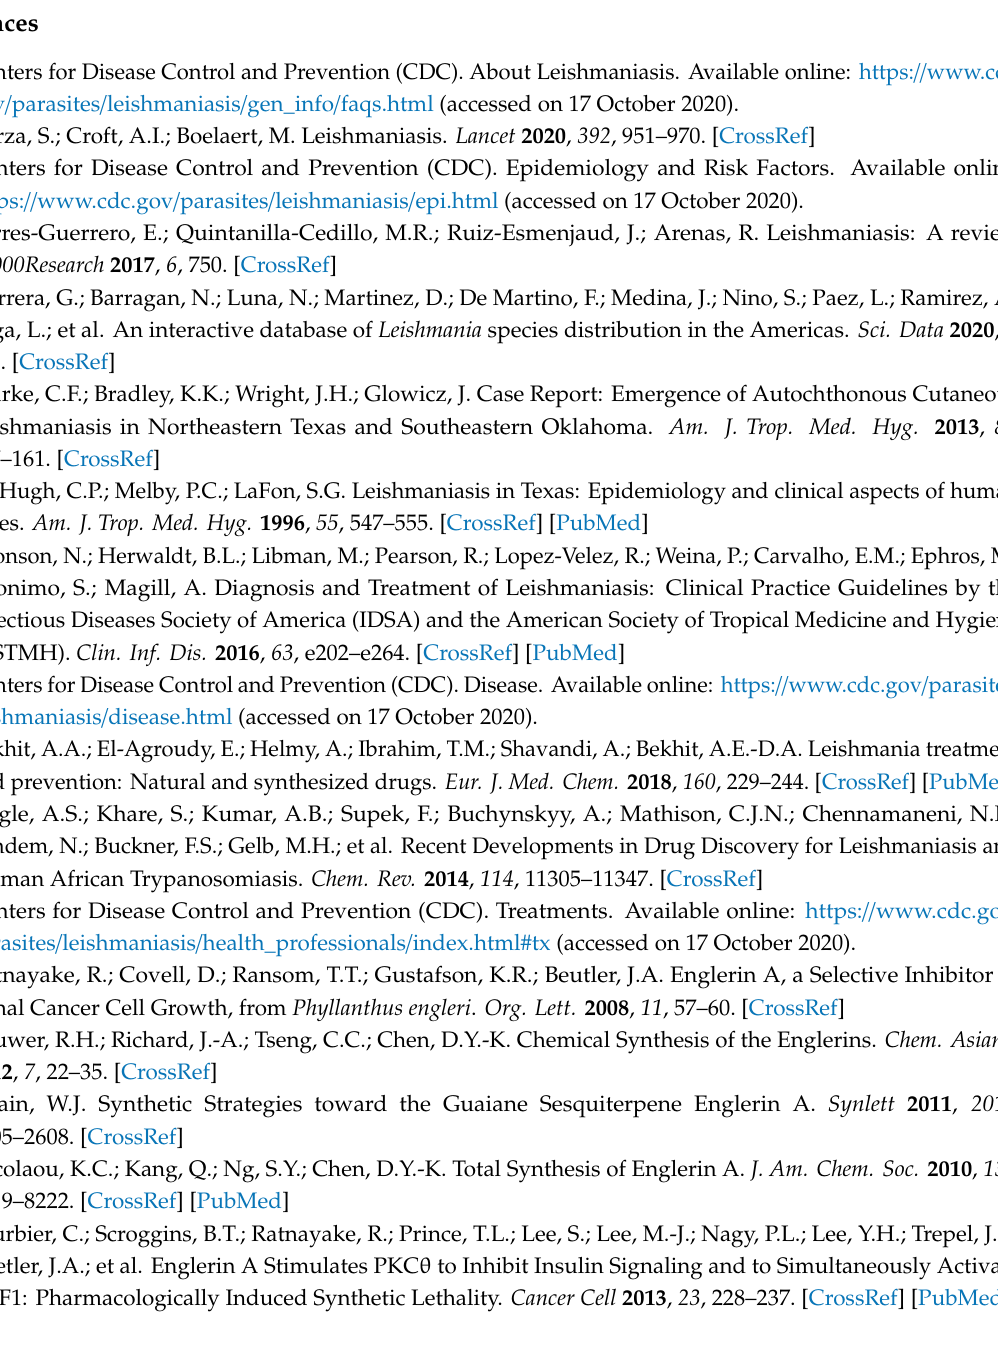
DMSO control cell pool, Figure S16. Overlay image of compound 1b incubation, Figure S17. Overlay image of compound 1c incubation, Figure S18. Overlay image of compound 1e incubation, Figure S19. Overlay image of mixed incubation of compounds 1b + 1e , Figure S20. Overlay of mixed incubation of compounds 1c + 1e